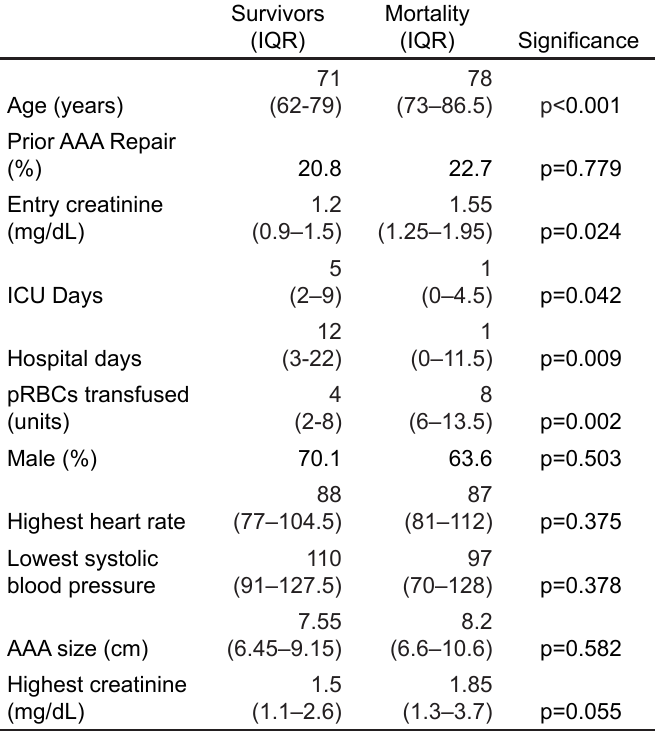
Table 2. Comparison of patients with ruptured abdominal aortic aneurysm: survivors and